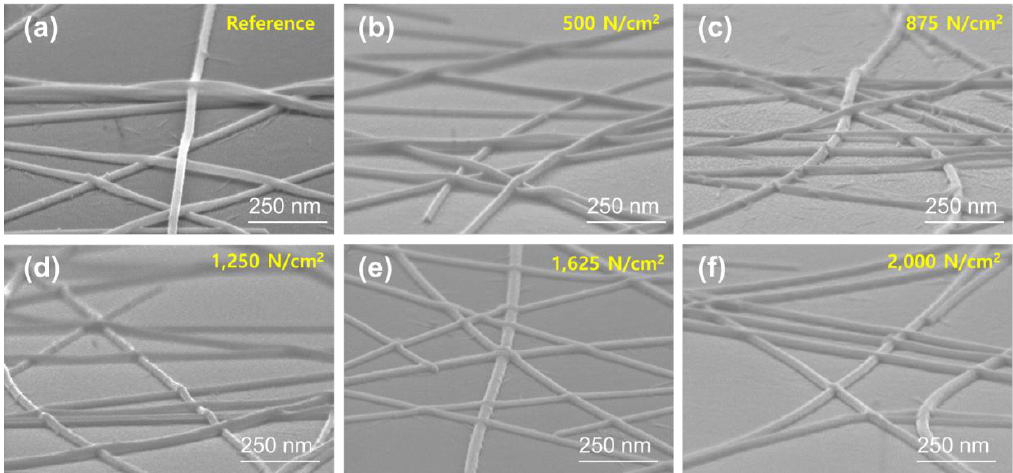
Figure 3. SEM images of the AgNW networks with 20 sprayings before pressurizing ( a ) and after pressurizing with the vertical pressures of ( b ) 500; ( c ) 875; ( d ) 1250; ( e ) 1625; and ( f ) 2000 N/cm 2. .